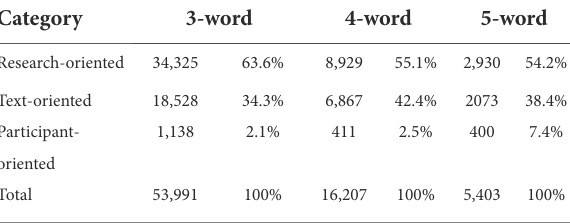
TABLE 5 Functional distribution of three-, four-, and five-word